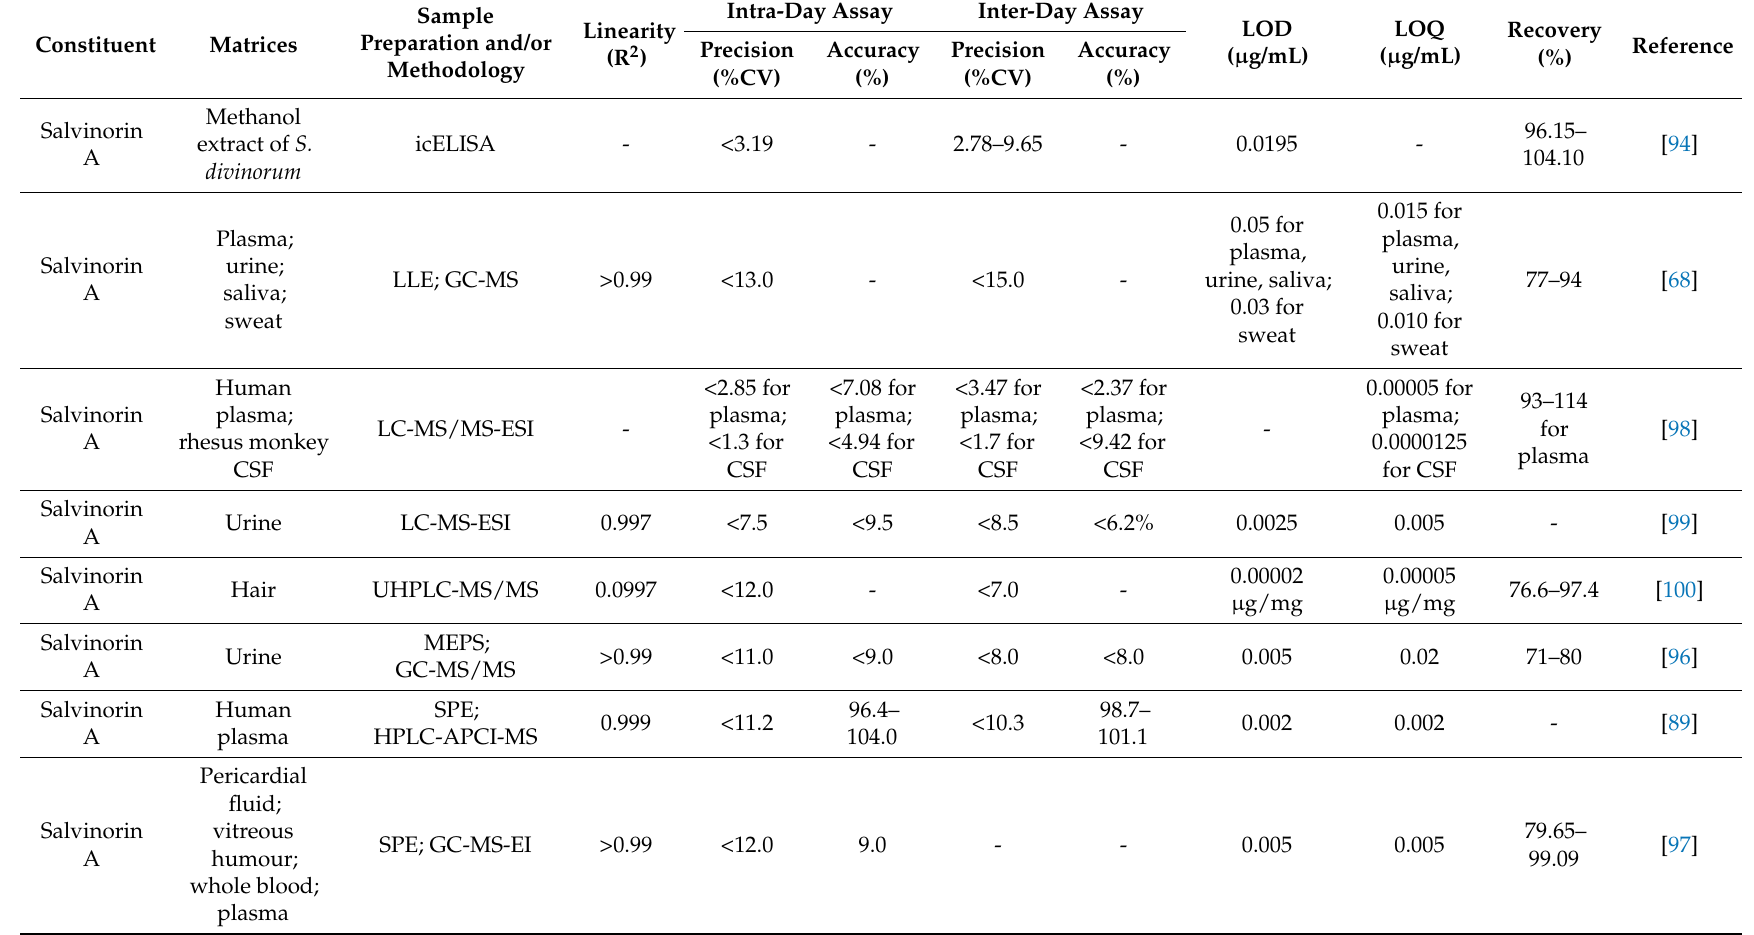
Table 2. Detection and quantification of salvinorin A in biological matrices and S. divinorum plant